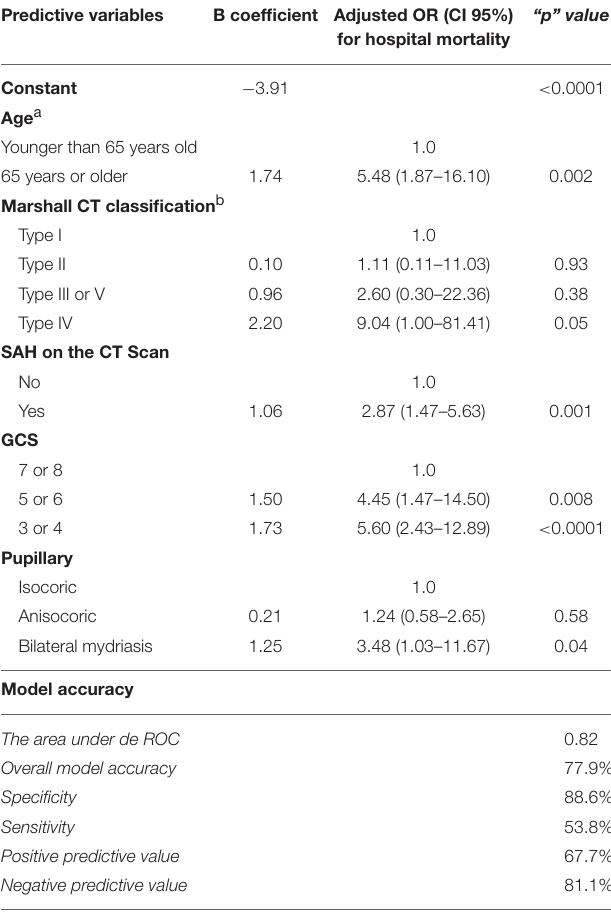
TABLE 2 | The clinical, demographic, radiological, and neurosurgical variables independently associated with a hospital mortality of patients admitted with severe traumatic brain